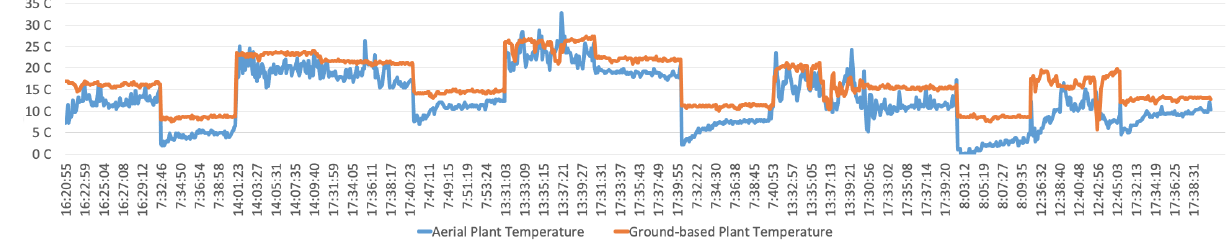
Figure 7. Aerial infrared data compared with ground-based infrared data.